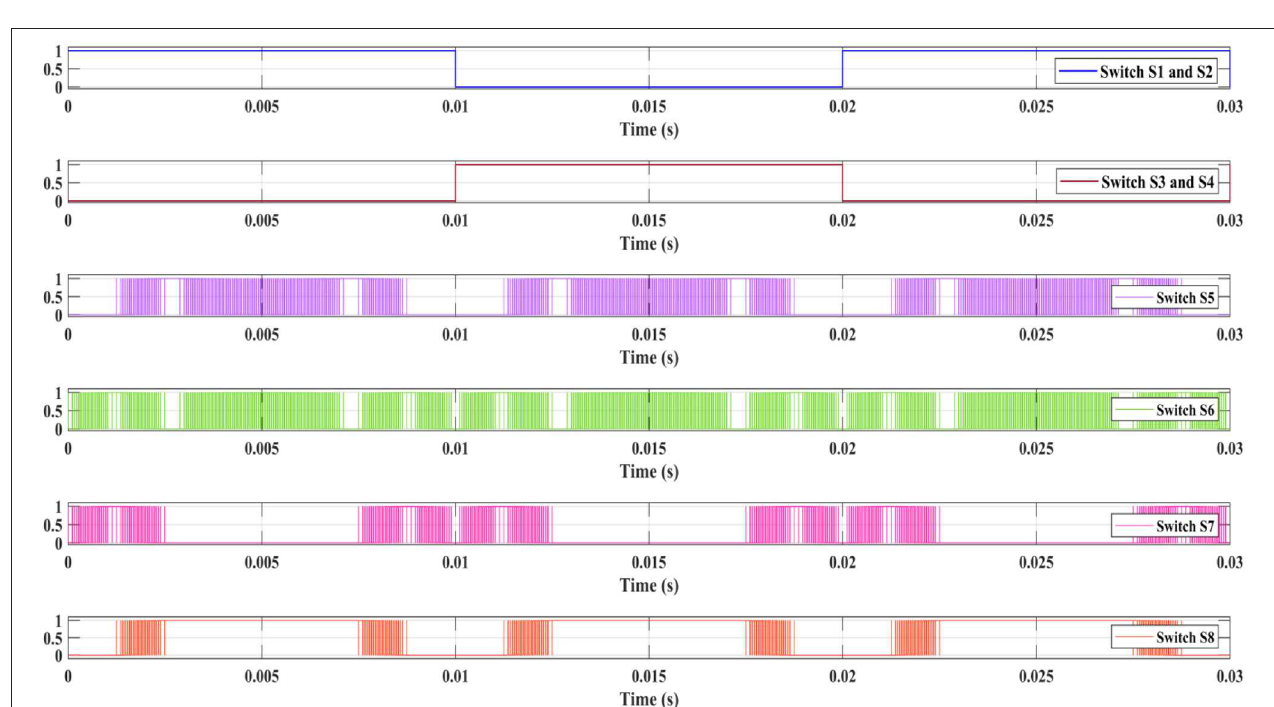
FIGURE 8 | Pulse sequence of DCL MLI.